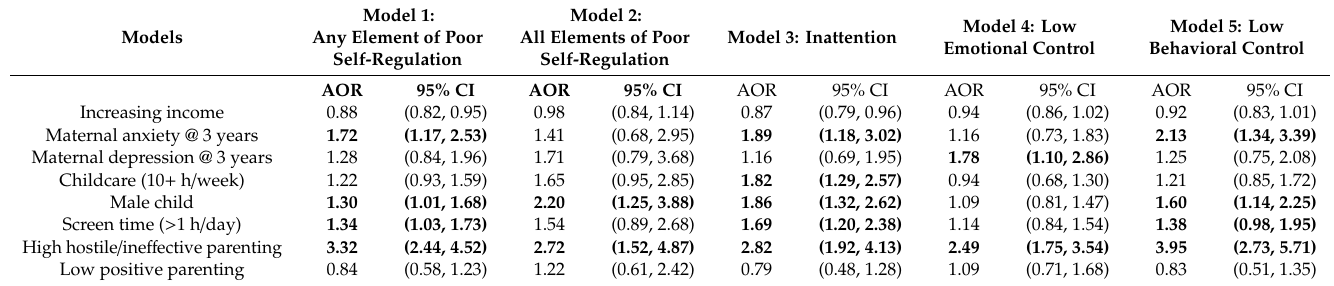
Table 2. Adjusted odd ratios (AOR) for poor